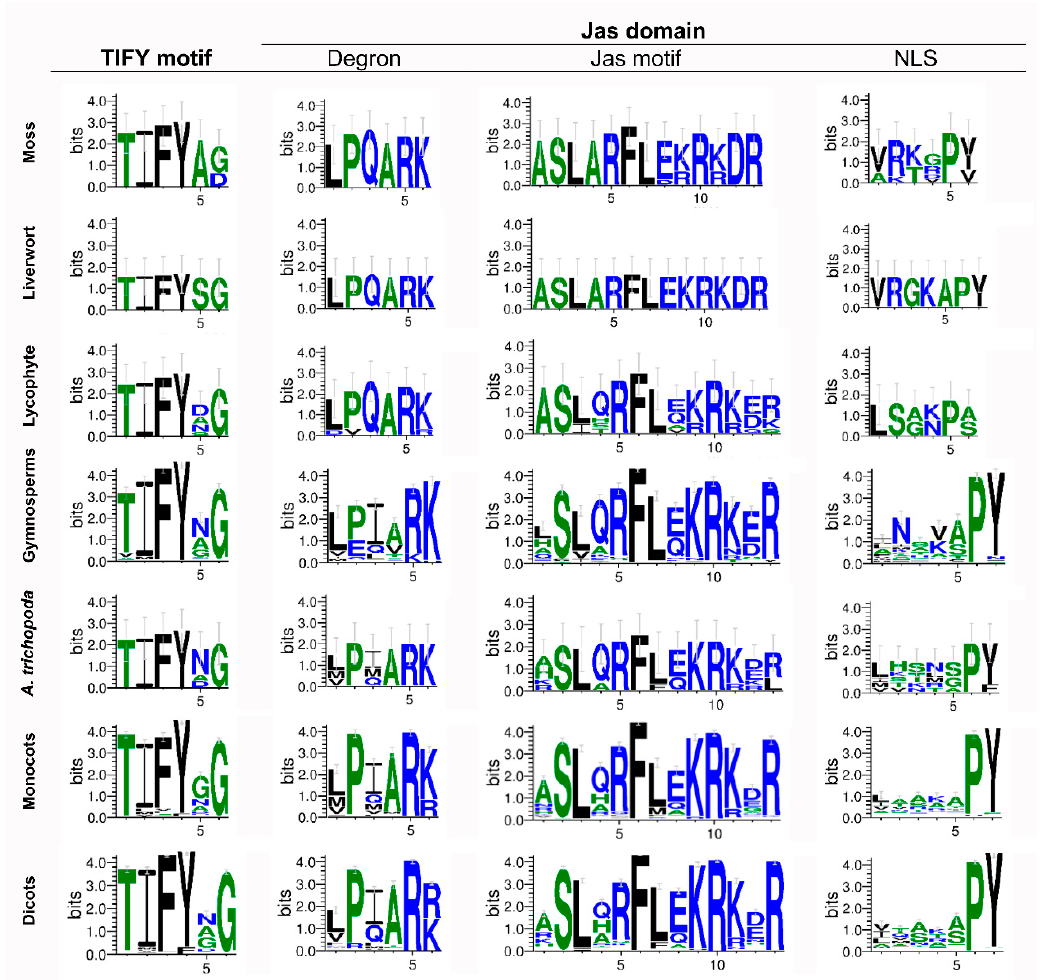
Figure 2. Consensus sequences of the TIFY motif and the Jas domain for different lineages in the plant kingdom. TIFY motif logo sequence and Jas domain showing degron, Jas motif and Nuclear Localization Signal (NLS) logo sequences. Logo sequences of the TIFY motif were obtained from 9, 1, 8, 159, 6, 287 and 515 sequences for moss, liverwort, lycophyte, gymnosperms, Amborella trichopoda , monocots and dicots, respectively. Logo sequences of the degron were obtained from 9, 1, 8, 167, 6, 287 and 516 sequences for moss, liverwort, lycophyte, gymnosperms, A. trichopoda , monocots and dicots, respectively. Logo sequences of the Jas motif were obtained from 9, 1, 8, 195, 6, 303 and 543 sequences for moss, liverwort, lycophyte, gymnosperms, A. trichopoda , monocots and dicots, respectively. Logo sequences of NLS were obtained from 7, 1, 2, 168, 6, 278 and 510 sequences for moss, liverwort, lycophyte, gymnosperms, A. trichopoda , monocots and dicots, respectively. JAZ proteins lacking the TIFY motif were not included in the analysis. For more details, see the Materials and Methods